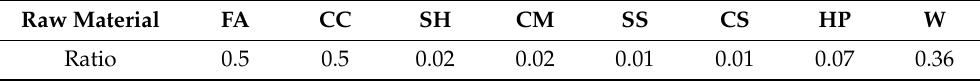
Table 1. The ratio design for FBLPG. Raw